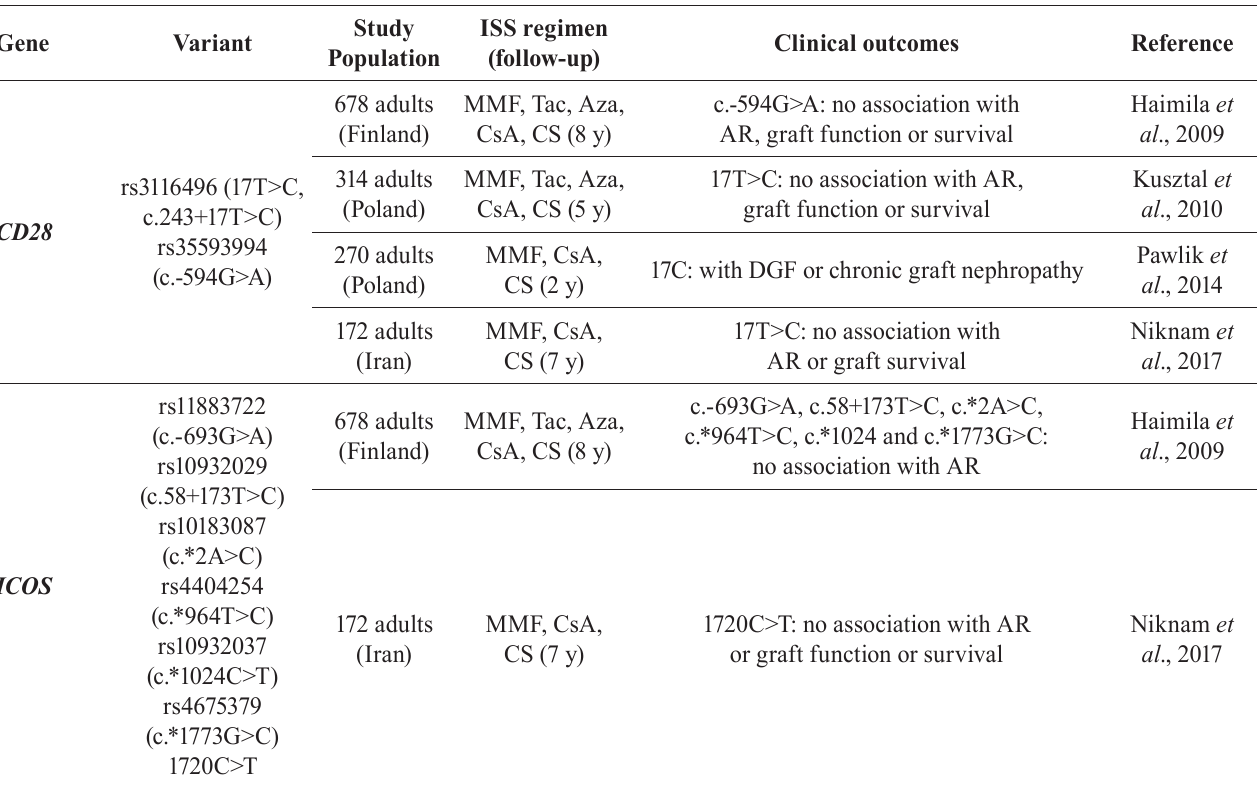
TABLE II - Genes related to T cell activation in kidney recipients on MPA therapy Gene Variant